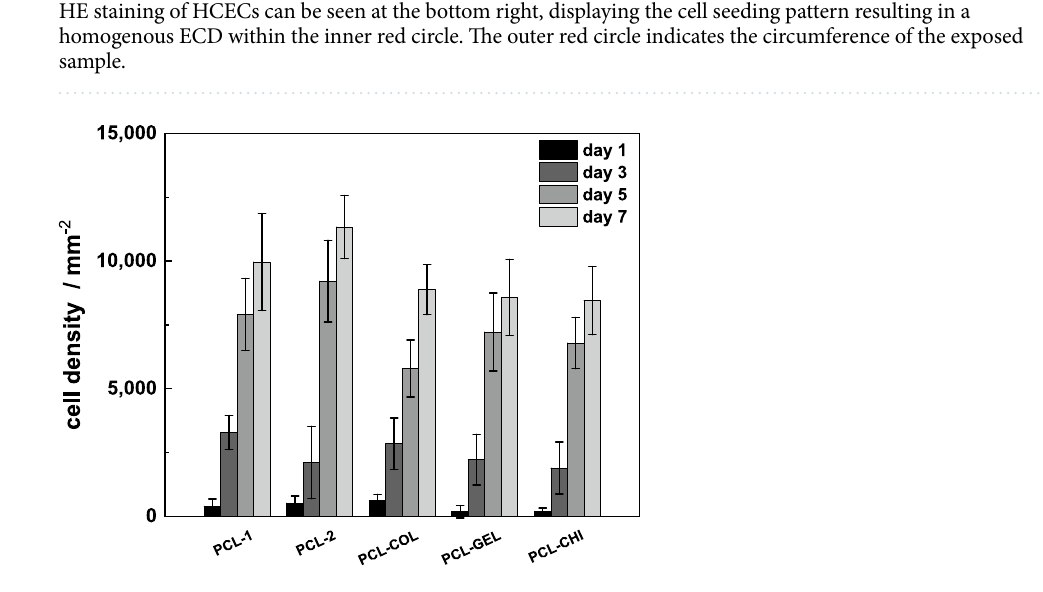
Figure 4. ECD for the different samples over an observation period of 7 days. Cells were seeded initially with an ECD of 700 cells per mm 2